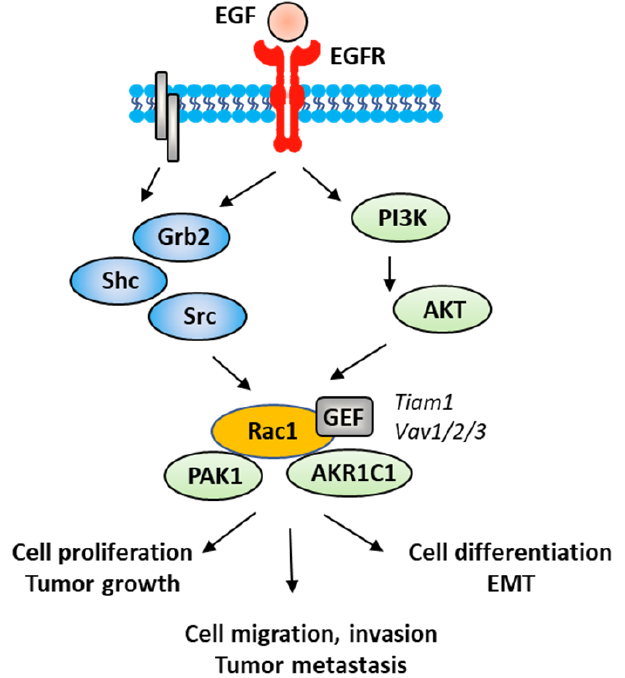
Figure 5. A signaling network between EGFR and Rac1, in vascular smooth muscle cells with various signaling effectors implicated.